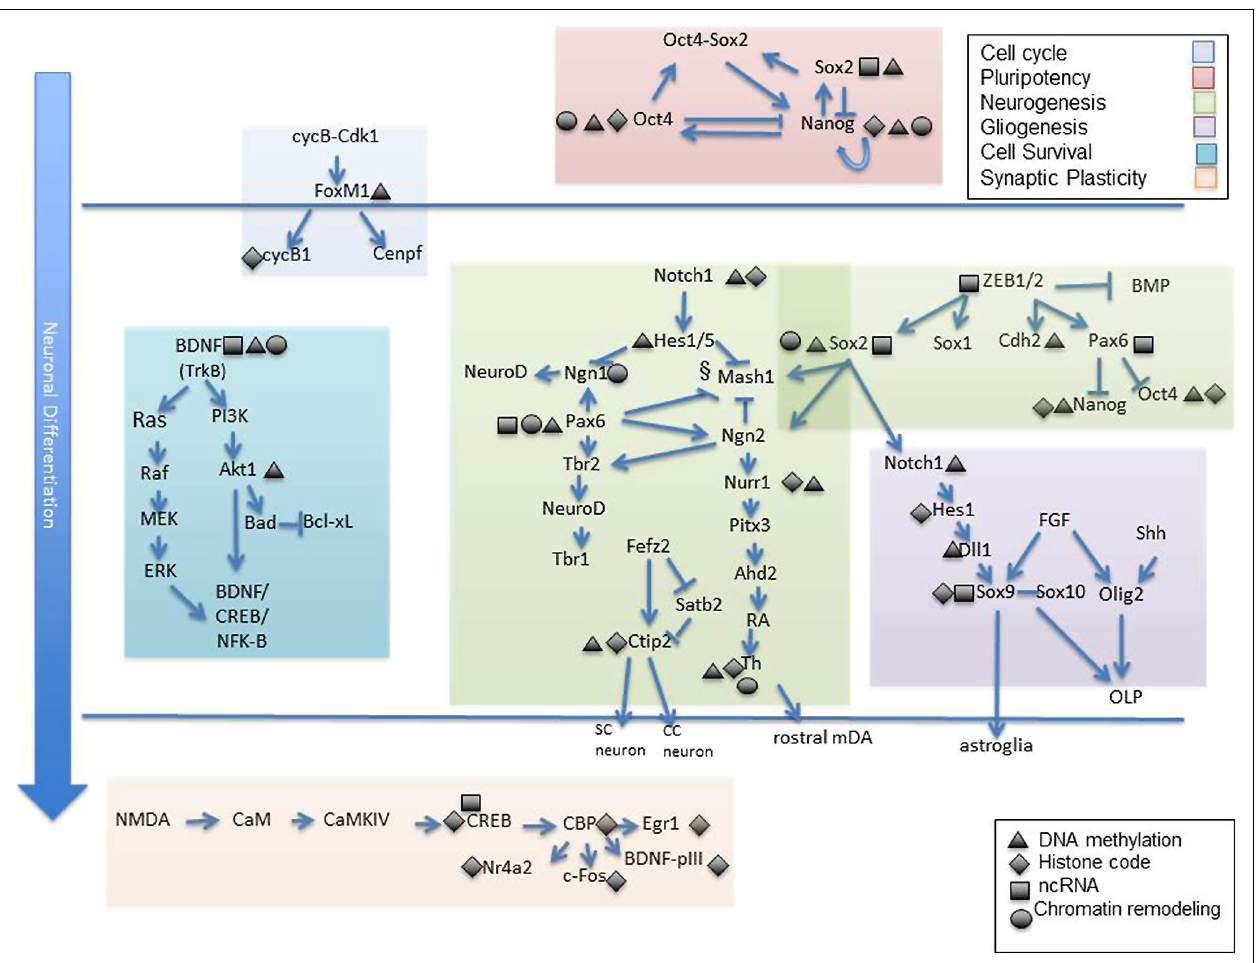
(shaded orange). Gene targets know to exhibit epigenetic sensitivity are depicted as such via symbolic representation (black triangle, DNA methylation; black diamond, histone modification; black rectangle, non coding RNA, black cirlce; chromatin remodeling complex). Individual reference to each gene is made in the text. OLP, oligodendrocyte progenitors; SC, subcortical neuron; CC, corticocortical